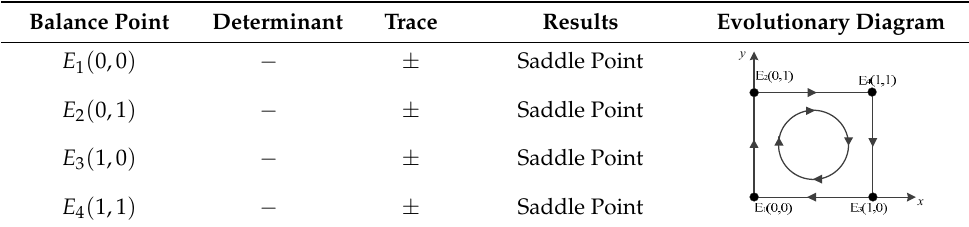
Table 7. Scenario 4: evolutionary game model steady state analysis. Balance Point